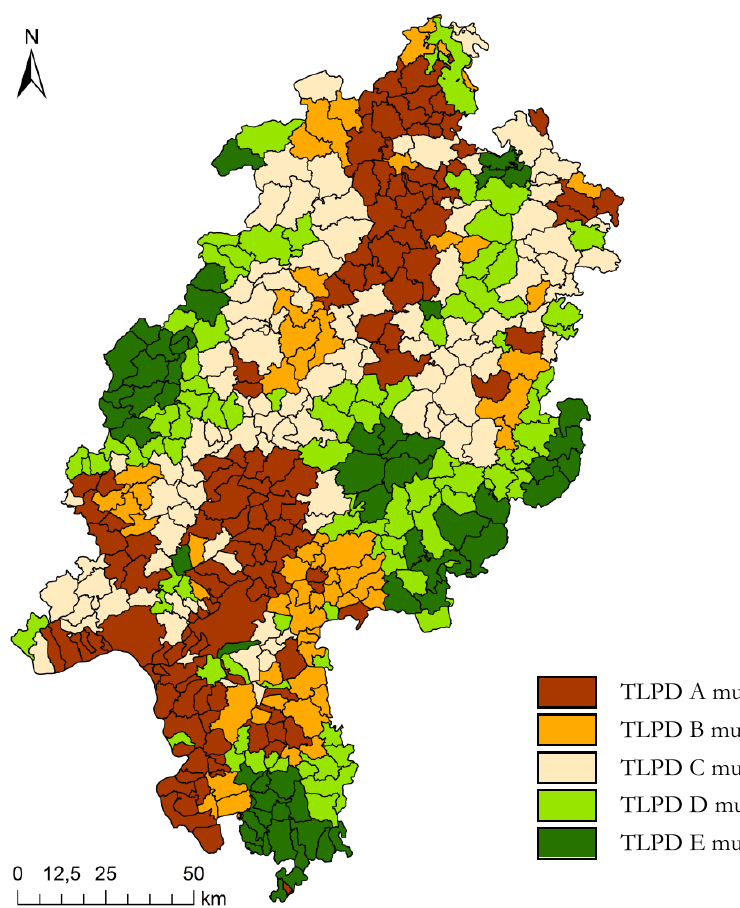
Figure 3. Spatial distribution of types of agricultural land-use patterns and dynamics (TLPD A-E) in the study region Hesse, Germany; see text and Table 4 for Figure 3: Spatial distribution… 38